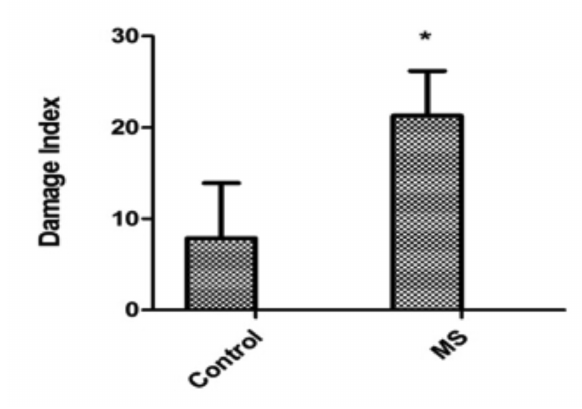
Figure 1 - DNA damage index in control and MS group. Note: *p < 0.05 Mann-Whitney Test.